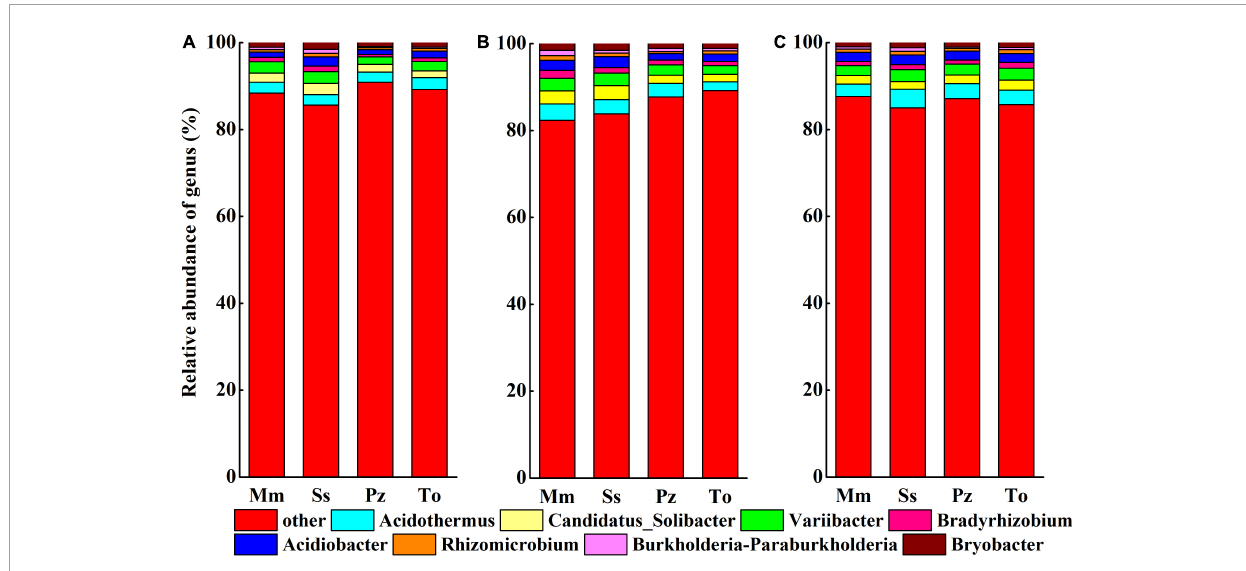
FIGURE2 Bacterial communities at the genus level in the rhizosphere soil of four broad-leaved trees species under 900 stems ha − 1 (A) , 1,200 stems ha − 1 (B) and 1,875 stems ha − 1 (C) of stocking density. The Mm, SS, Pz and To stand for Michelia macclurei , Schima superba , Phoebe zhennan, and Tsoongiodendron odorum , respectively.